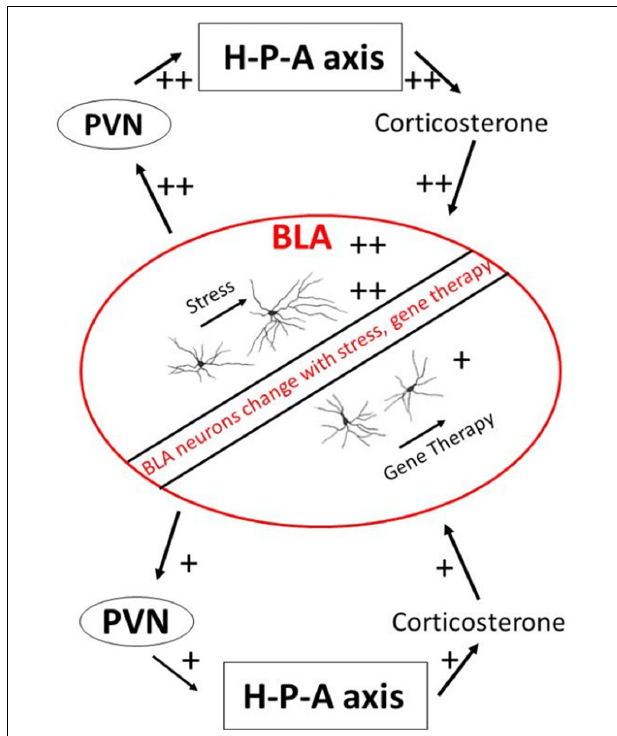
FIGURE 1 | A schematic view of the BLA and stress endocrine response. BLA, basolateral amygdala; H-P-A axis, hypothalamus-pituitary-adrenal axis; PVN, paraventricular nucleus of